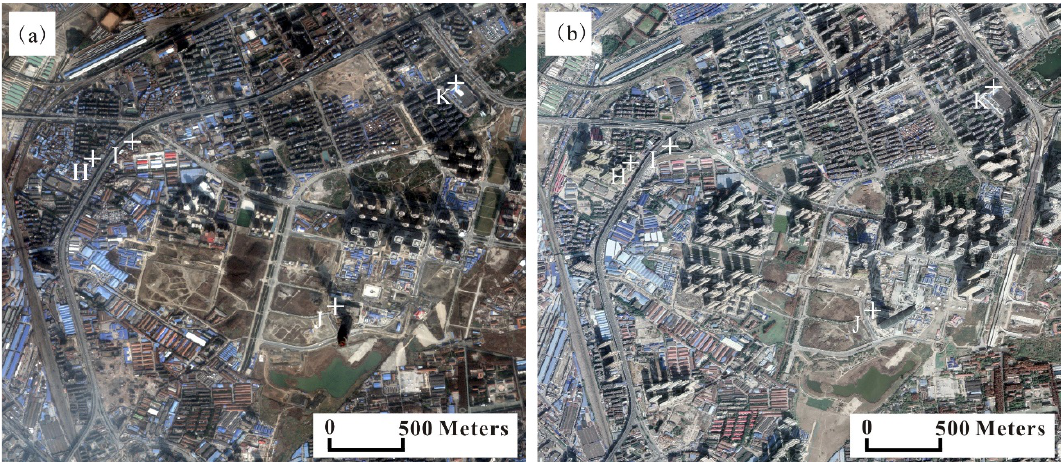
Sensors 2019 , 19 , x FOR PEER REVIEW 14 of 18 Figure 12. Maps show the satellite images of Region 2 on 21 January 2015 ( a ) and 9 December 2017 ( b ). Figure 12. Maps show the satellite images of Region 2 on 21 January 2015 (a) and 9 December 2017 (b) .